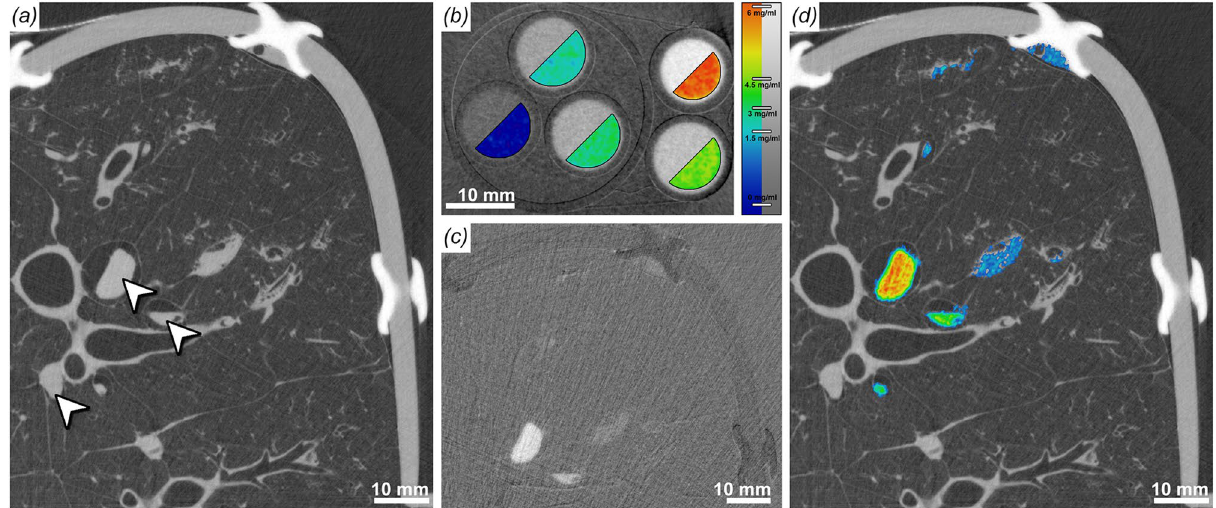
Figure 6. Iodine k-edge subtraction imaging (KES). ( a ) Shows a representative cross-section through a scan (33 keV) of a pig lung injected with different concentrations of iodine/agarose gel mixes. The white arrows point to vessels filled with the contrast agent. Differences in iodine concentration can not be observed. ( b ) CT scan of a phantom with known iodine concentrations (overlaid in pseudo-color), from which an iodine concentration calibration function was retrieved (color bar right). ( c ) The Subtraction image of two scans at 33.5 and 33 keV demonstrates a high specificity for iodine, which in turn allows to quantify difference in the iodine concentration. ( d ) Quantification of the iodine concentrations (color coded) using the calibration function ( b ).